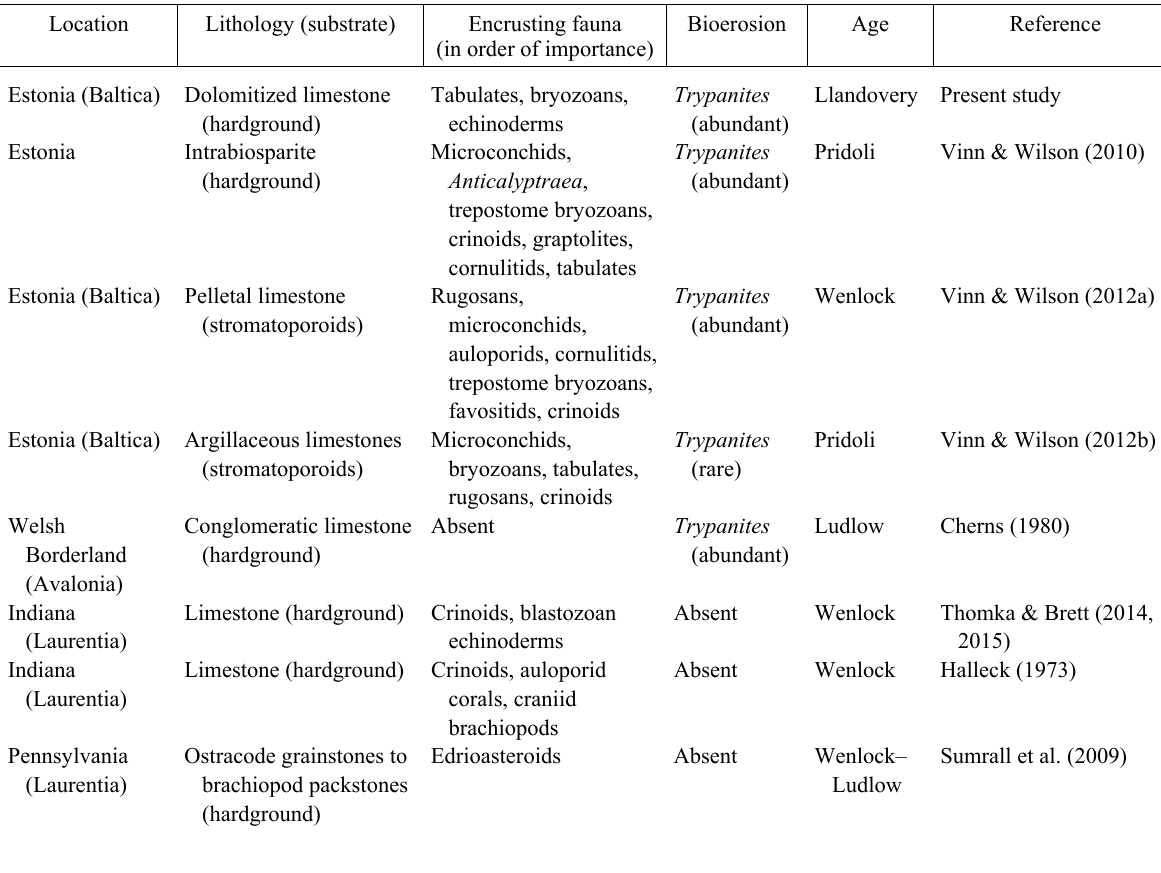
Table 1. Silurian hard substrate faunas from Estonia and